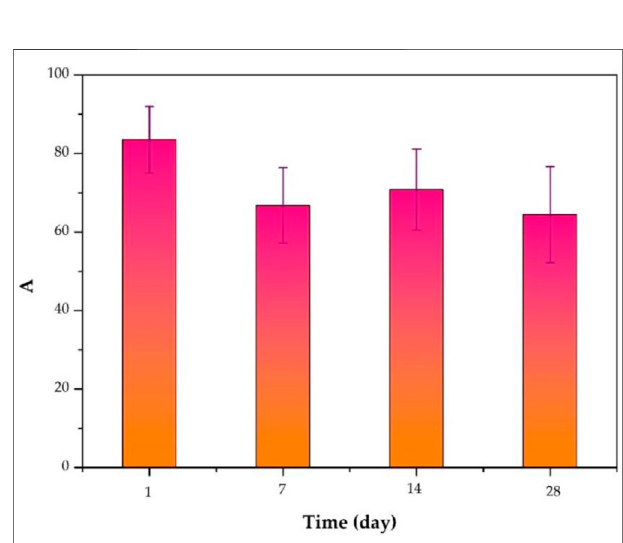
FIGURE 6 | Inhibition of S. aureus bio fi lm formation by the release solution of the cipro fl oxacin-loaded PTMC implants at day 1, day 7, day 14, and day